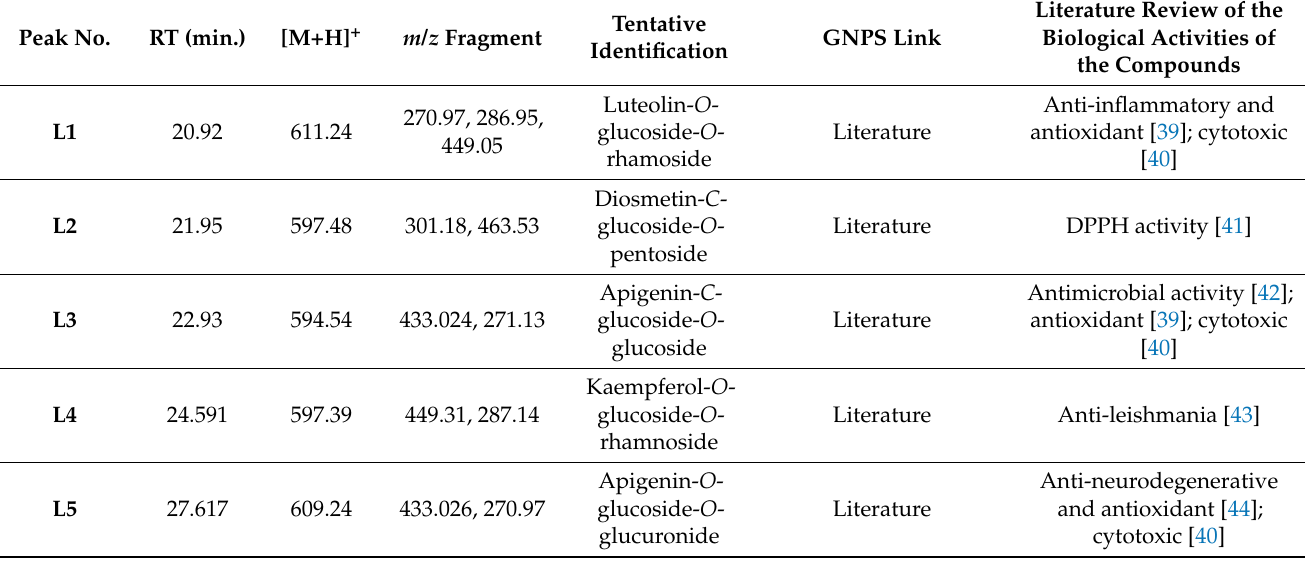
Table 2. Compounds ( L1 – L14 ) identified from A. hierochuntica .